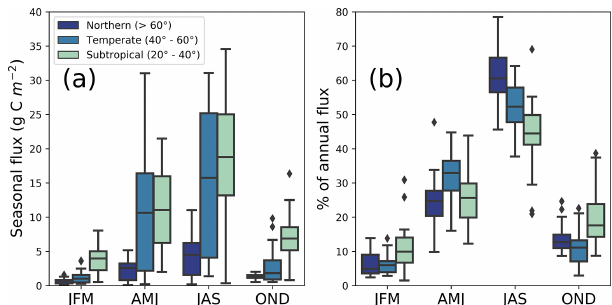
Figure 9. (a) Quarterly contribution to total annual CH 4 flux (in gCm − 2 ) and (b) percentage of annual CH 4 flux. Sites were di- vided into northern ( > 60 ◦ N), temperate (40–60 ◦ N), and sub- tropical (20–40 ◦ N). Quarters with continuous data gaps exceed- ing 30d were excluded. We used the following quarterly pe-